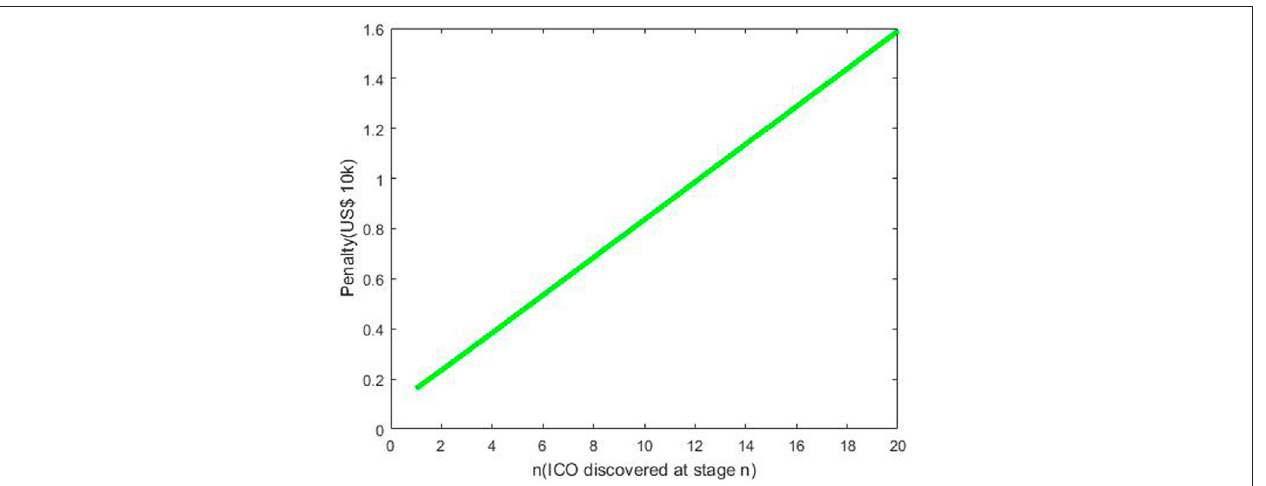
FIGURE 4 | Increase in penalties for TFT of the changes in stage at which illegal production is discovered.